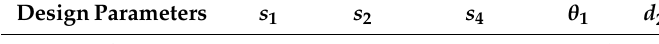
Figure 7. ( a ) Kinematics of input motion (slide motion) and output motion (wing root rotation). ( b ) Graph of relationship between θ r and d 2 to define d 2 with respect to desired θ r (30 ◦ ). Table 2. Design parameters of wing root rotation mechanism.